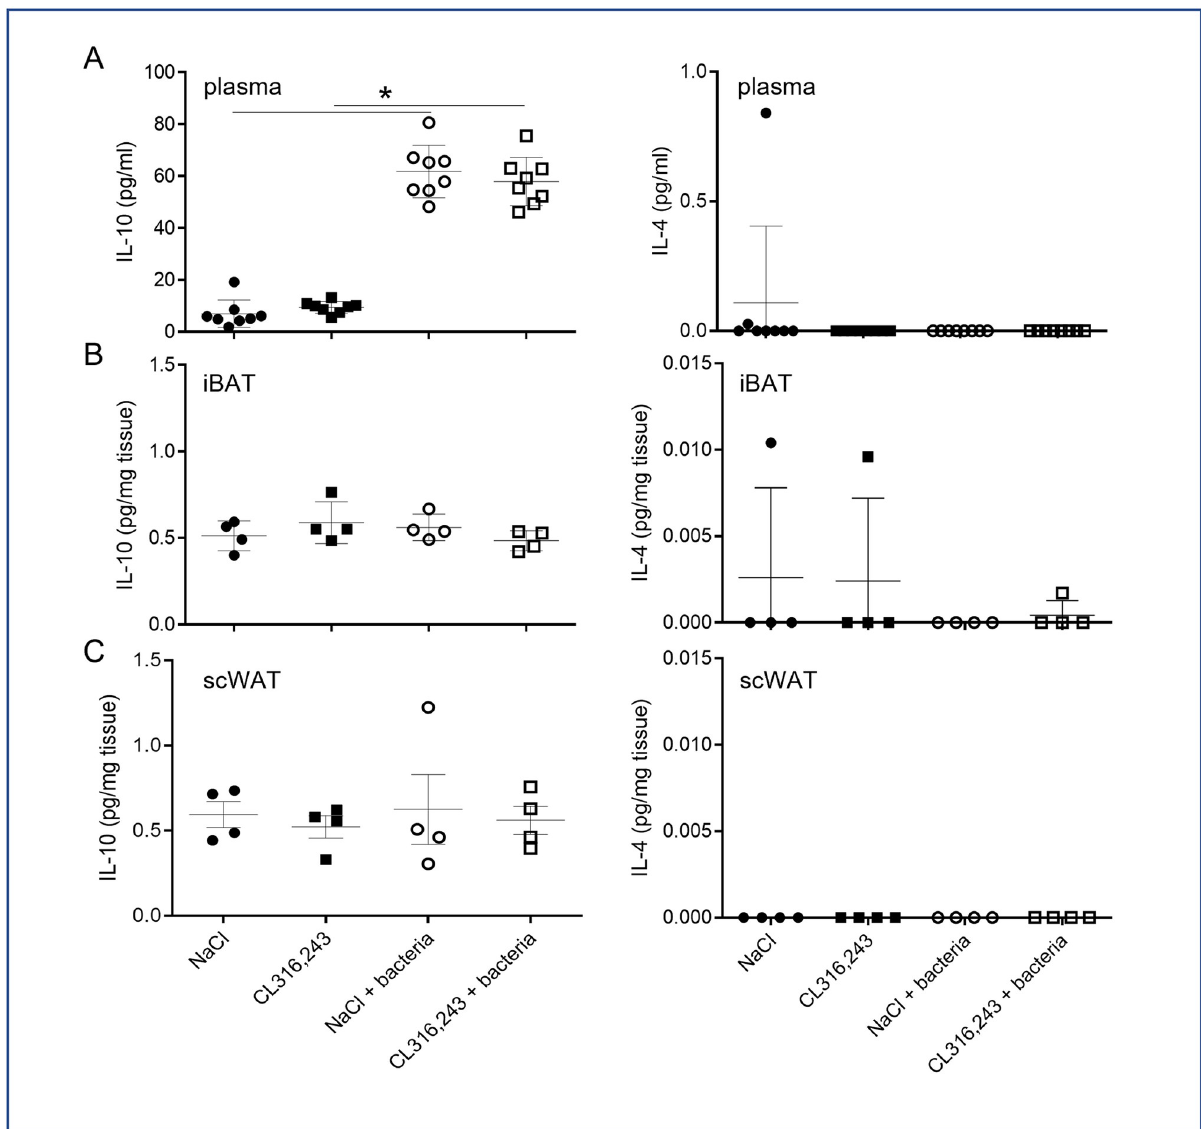
Fig 5. Systemic and local anti-inflammatory response to bacteria. IL-4 and IL-10 levels were assessed in plasma (A) and in the media of iBAT (B) and scWAT (C) explants from mice that were treated for 1 week with CL316,243 daily (1 mg/kg/day) or vehicle only (NaCl), and infected with E . coli for 48 hours. The results are displayed as independent values (dots) and the mean ± SD. n = 8 (plasma) or 4 (explant). � p <